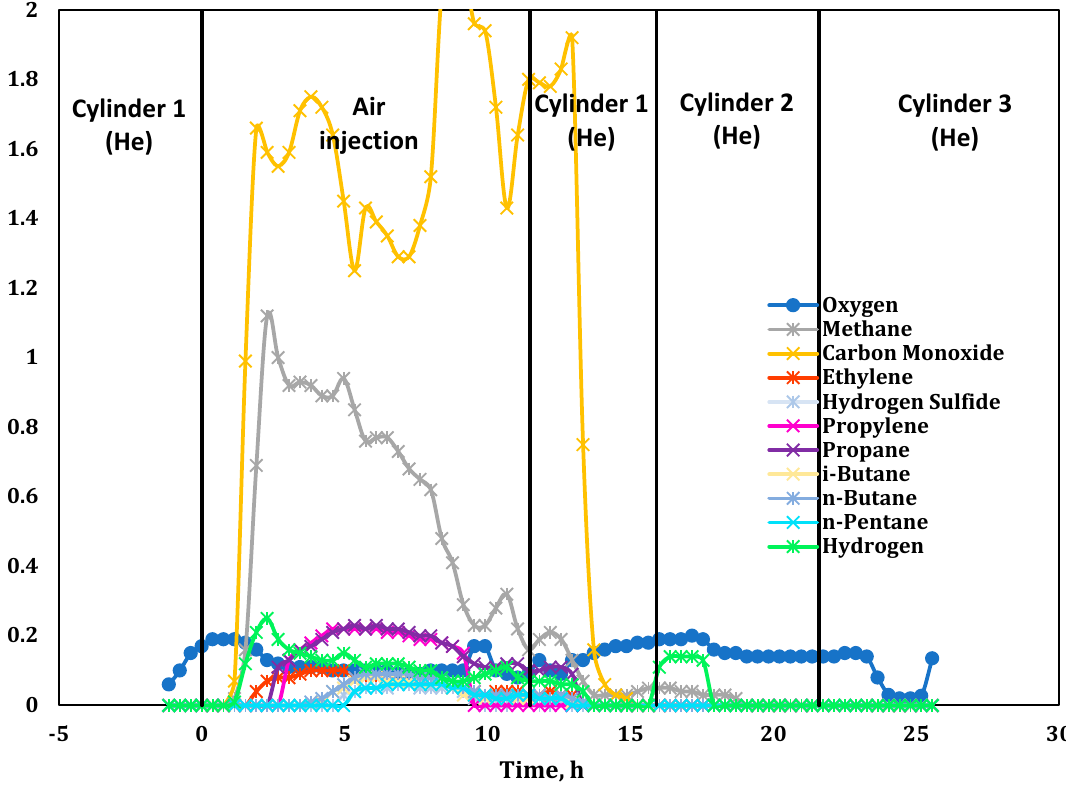
Figure 10. Composition of produced gas, including He (expanded Y-scale). The rate of the produced gas (see Figure 11) showed an increased product gas flow associated with a leak from the pressure jacket. It was found near the core pack outlet or production line. Vertical black colored lines indicate the switch from helium to air and back to helium injection.